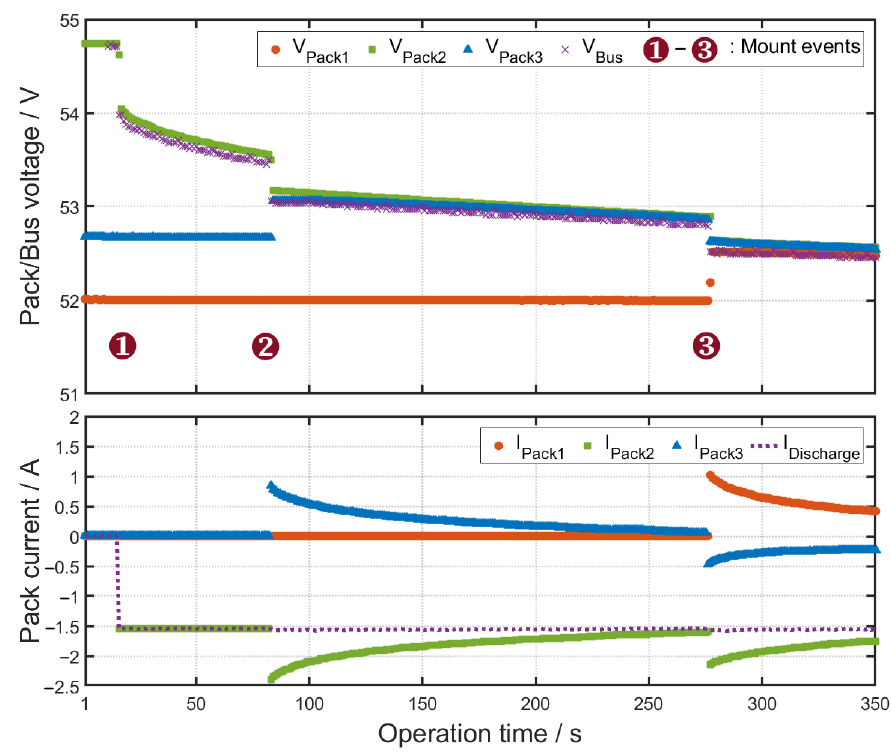
Figure 12. Enlarged view of the sequential mounting events at the initiation of a battery pack discharging cycle.